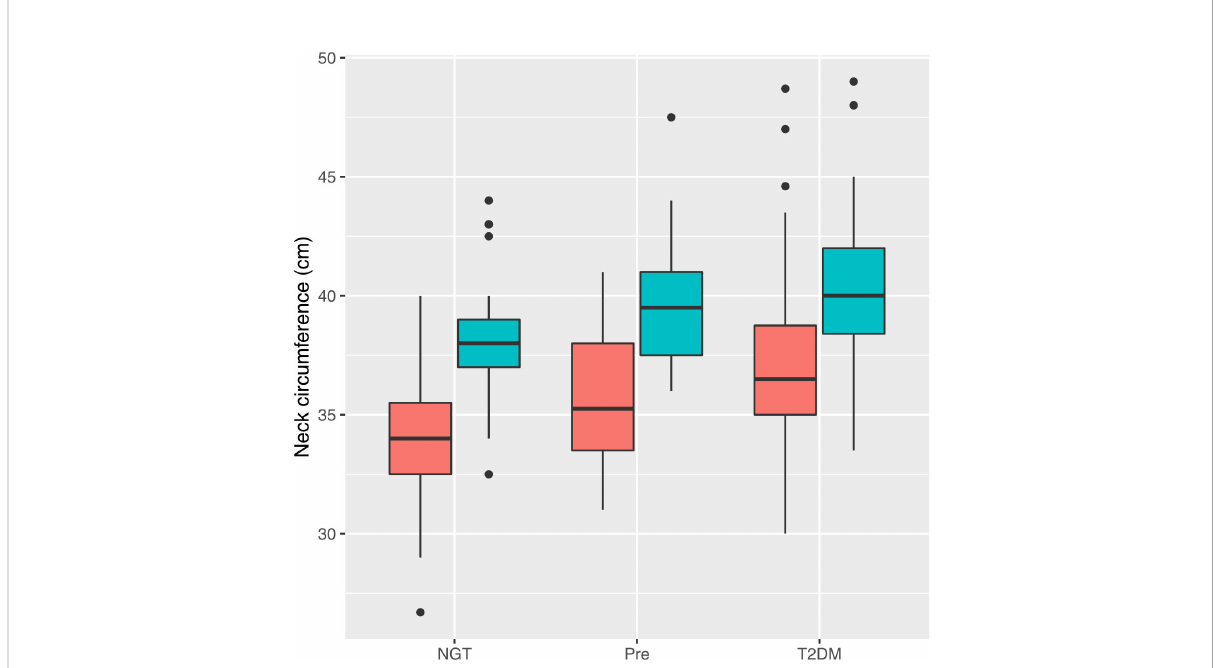
FIGURE 1 Relationship between neck circumference and glycemic status strati fi ed by sex. Tukey plot represents median, interquartile range (IQR) and IQR ± 1.5 * IQR. Male participants are represented by blue and female participants by red. NGT, normal glucose tolerance; Pre, prediabetes; T2DM, Type 2 diabetes